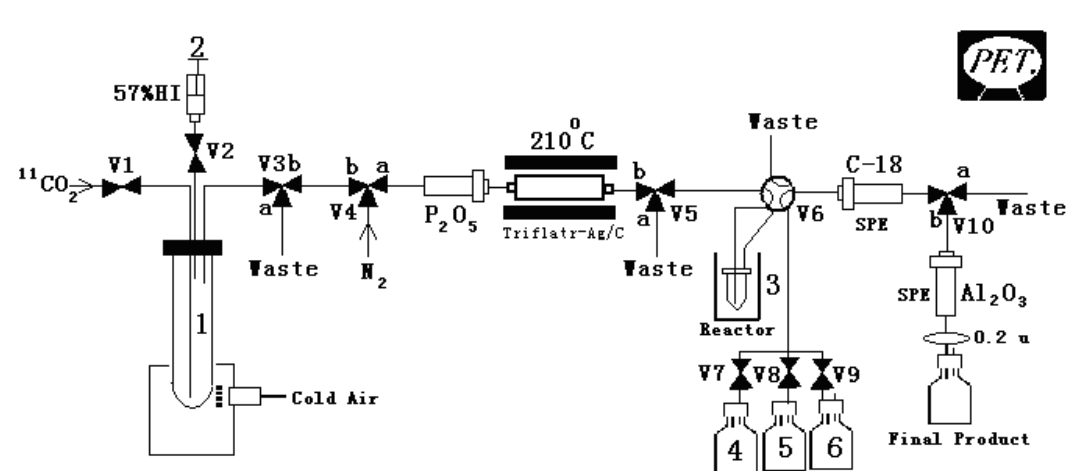
Figure 4. A scheme of the synthesis